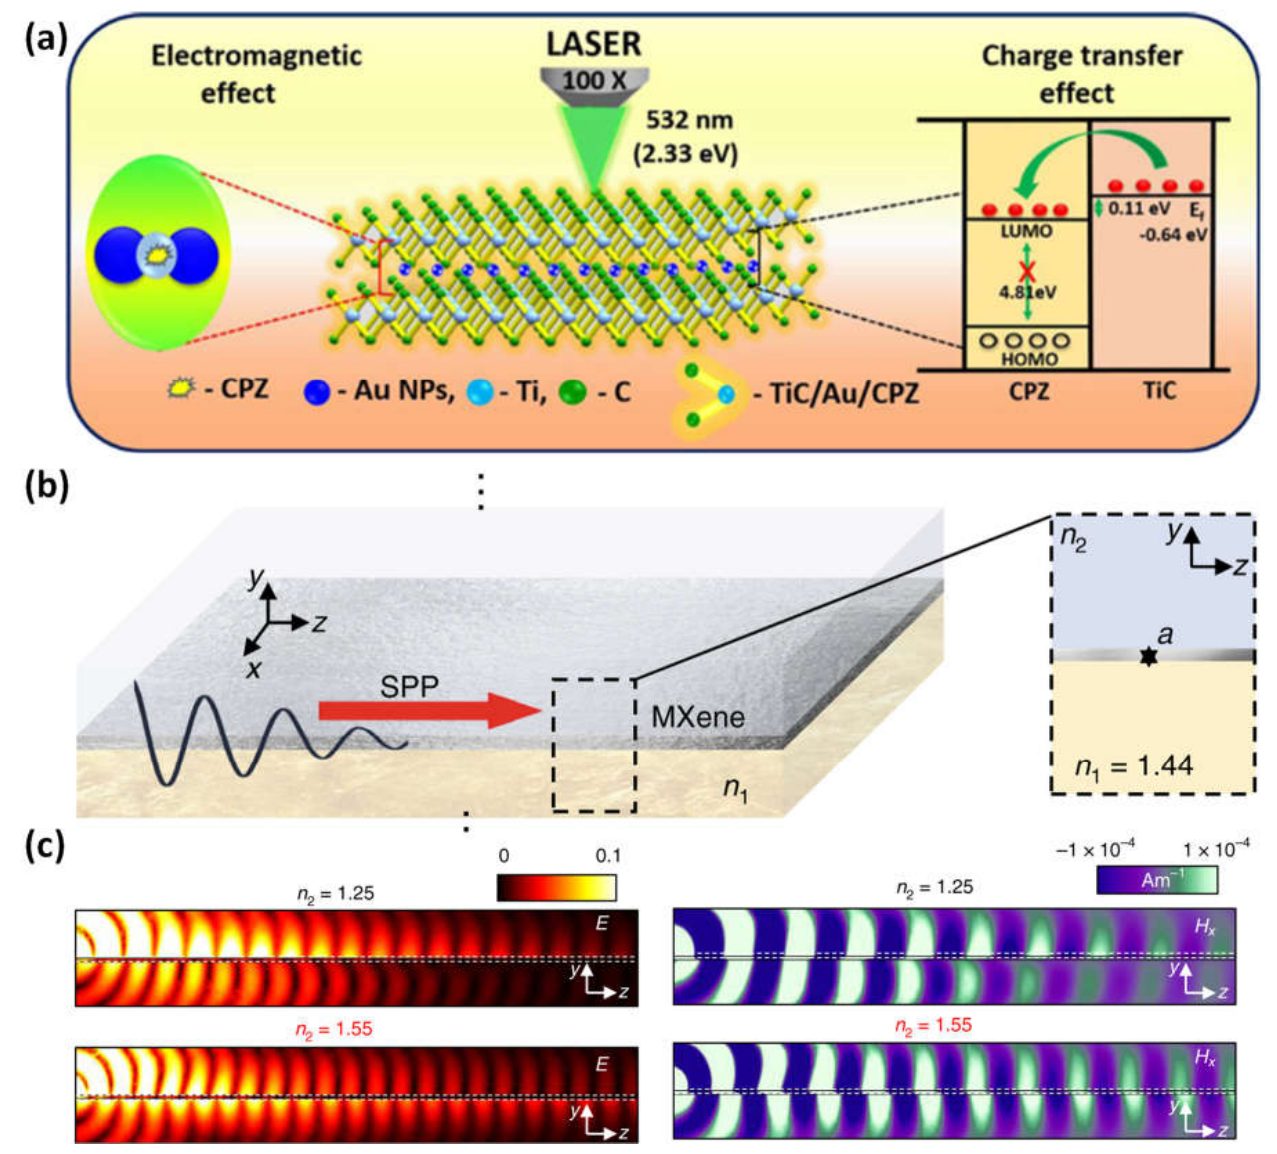
Figure 11. ( a ) The simple photoreduction procedure used to incorporate gold nanoparticles into MXene to increase its SERS activity to detect antipsychotic drugs; ( b ) a sketch structure of MXene, which consists of two semi-infinite media with the refractive indices n 1 (the bottom material, SiO 2 ) and n 2 (the top material), and Ti 3 C 2 T x sandwiched between two thin layers; ( c ) numerical findings for the distributions of Hx field and electric field on the yz planes, respectively, taking into account several materials for the top dielectric: n 2 = 1.25 (top) and n 2 = 1.55 (bottom). Reproduced with permission from references [88,96] .